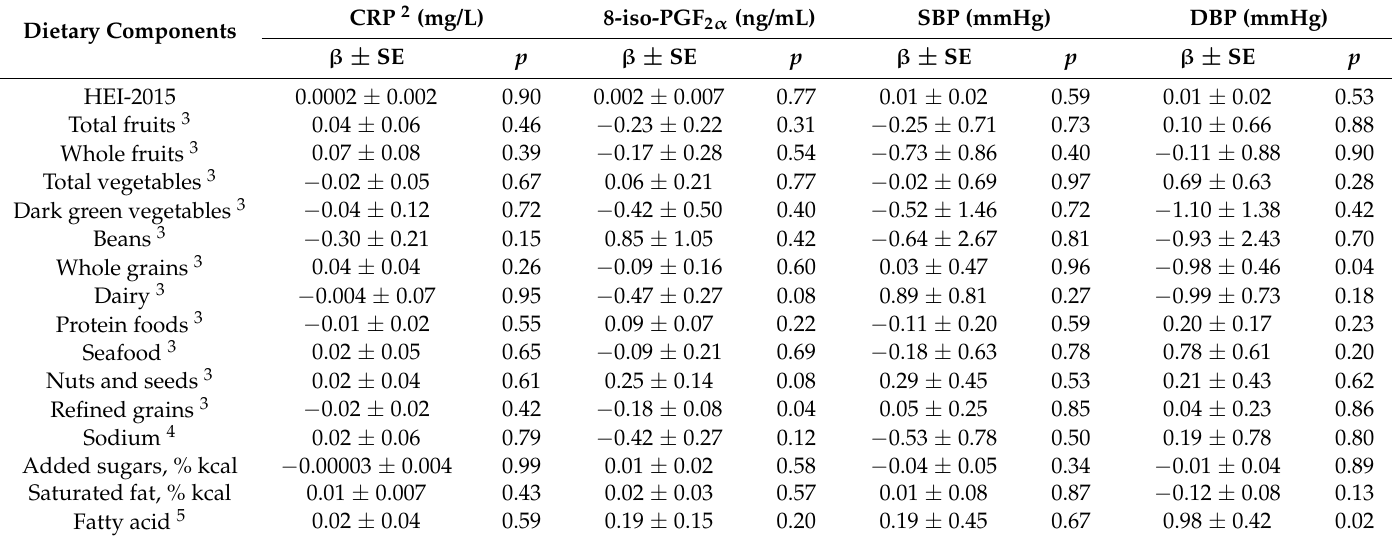
Table 4. Association of diet quality and food group and nutrient intake with inflammation, oxidative stress and blood pressure in youth with type 1 diabetes 1 . Dietary